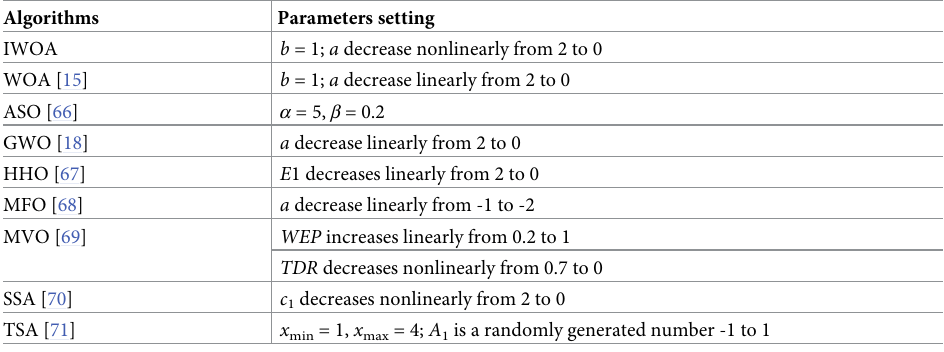
Table 3. Parameter settings of IWOA and other selected algorithms.